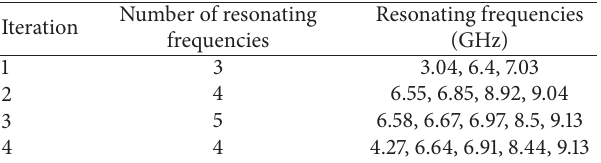
Table 1: Resonating frequencies of the CRA.